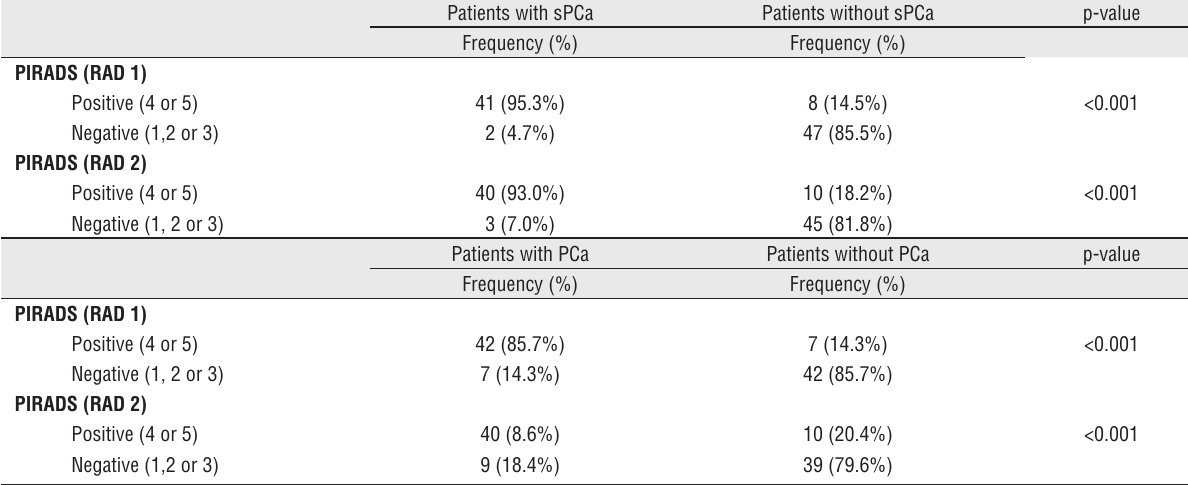
Table 5.1 - Numbers that allow estimation of the different diagnostic accuracy parameters.